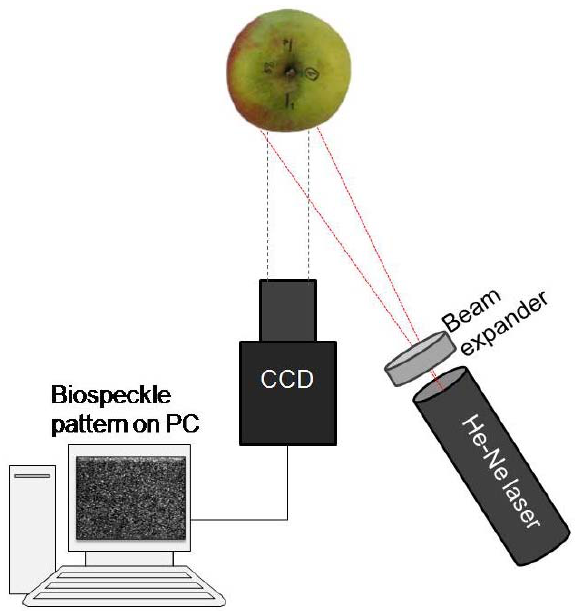
Figure 1. Scheme of the biospeckle